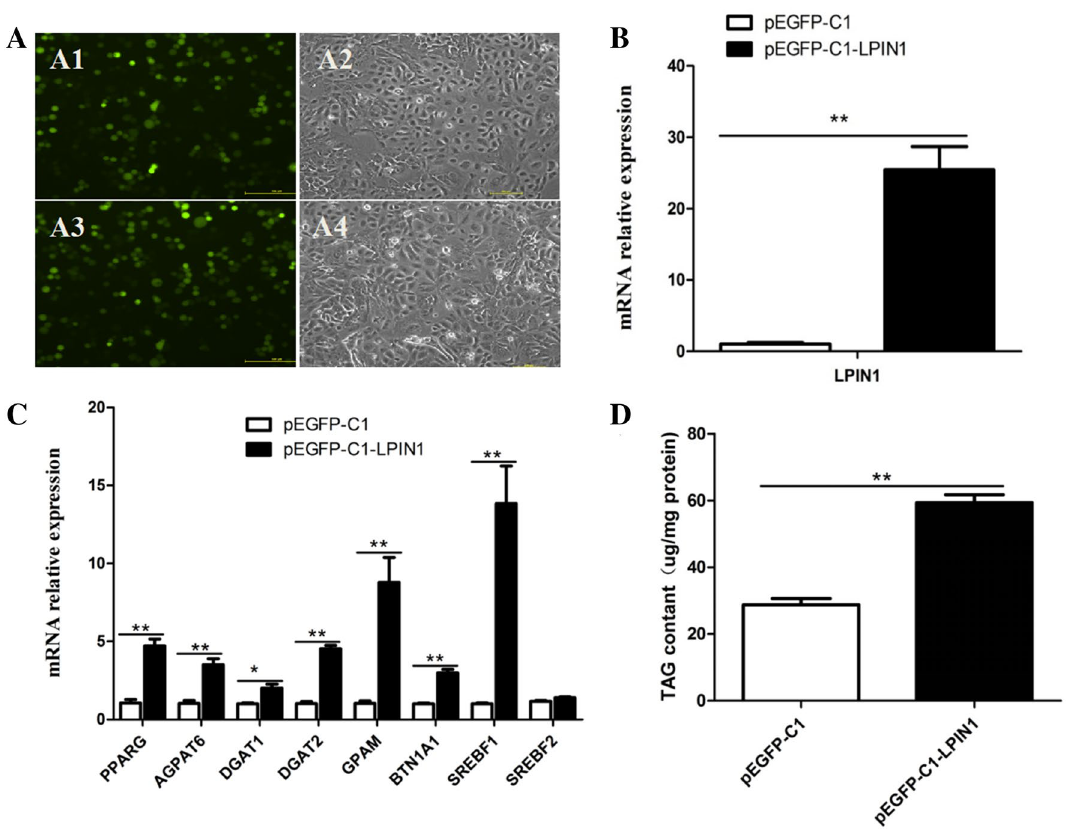
Figure 2. Effect of LPIN1 overexpression in the BMECs. ( A) Fluorescence results of LPIN1 overexpression in the BMECs. ( A1 ). Green fluorescence of control group (pEGFP-C1); ( A2 ) Ordinary light of control group (pEGFP-C1); A3. Green fluorescence of pEGFP-C1-LPIN1; A4. Ordinary light of pEGFP-C1-LPIN1; ( B ) The efficiency of LPIN1 overexpression; ( C ) The overexpression of LPIN1 up-regulates the expression of genes related to milk fat synthesis in the BMECs; ( D) Changes of total TAG content in the BMECs under the LPIN1 overexpression. Values are displayed as means ± SEM for three biological replicates. *, P < 0.05; **, P <